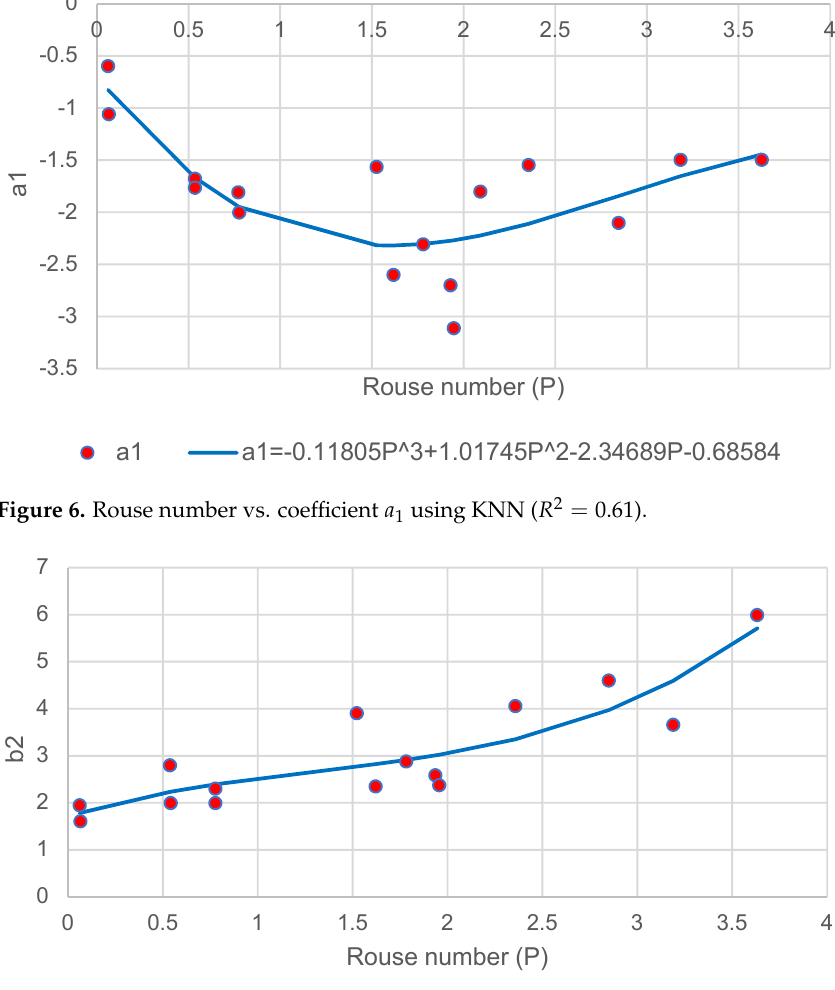
Figure 5. Rouse number vs. coefficient 𝑏 (cid:2869) using SVM ( 𝑅 (cid:2870) = 0.9148 ).